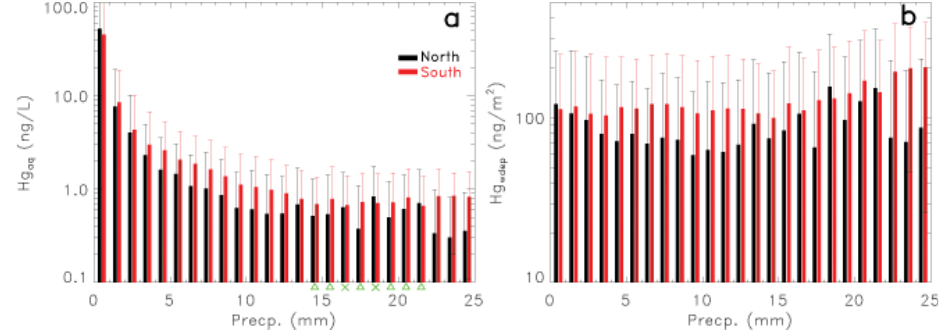
Fig. 11. Mercury concentration (a) and wet deposition (b) as a function of accumulated rainfall. The red and black bars show simulations initialized with radiosonde profiles from southern sites and northern sites,